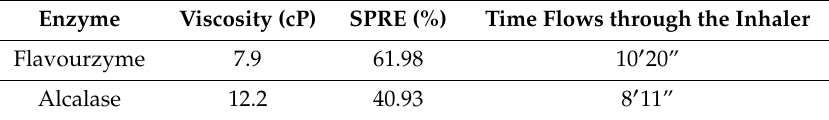
Table 7. Flow rate through feeding tubes of size 12F and particle size in soybean juice after hydrolysis using enzyme Alcalase and Flavourzyme.